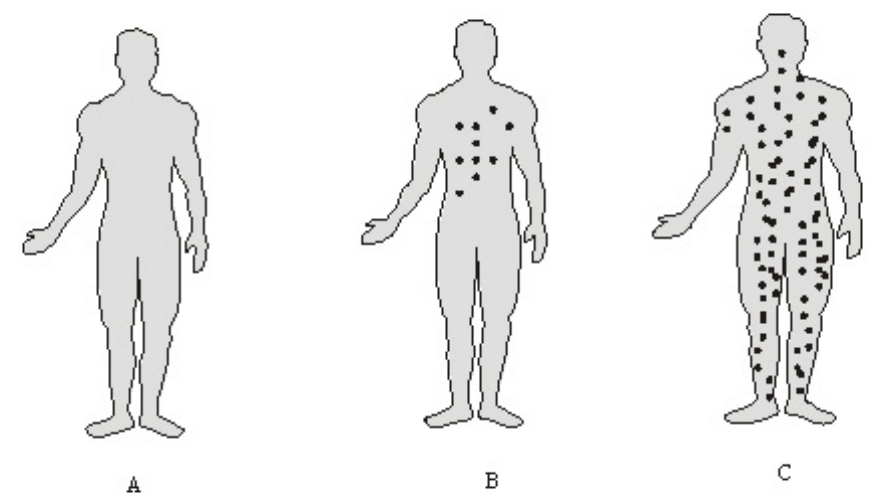
FIGURE 4. Individual diversity in the severity of a disease. A, totally resistant organism which contains no susceptible structures; B, mildly susceptible organism in which a few sensitive foci exists and the disease runs a benign course; C, organism in which the number of constitutionally susceptible structures is high and the disease develops in a severe